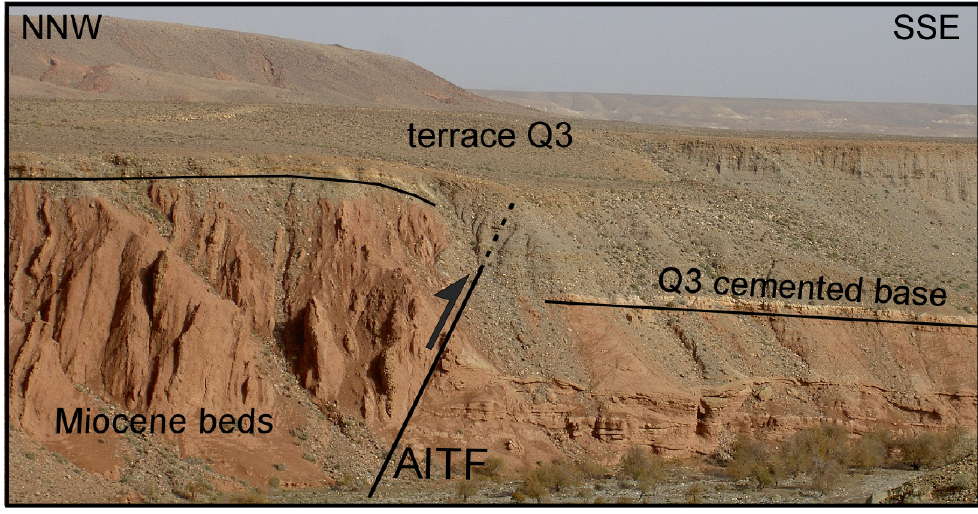
Figure 7. Interpreted image of the eastern slope of the Madri valley where the AITF offsets Q3. The field of view is 400 m (see location in Figure